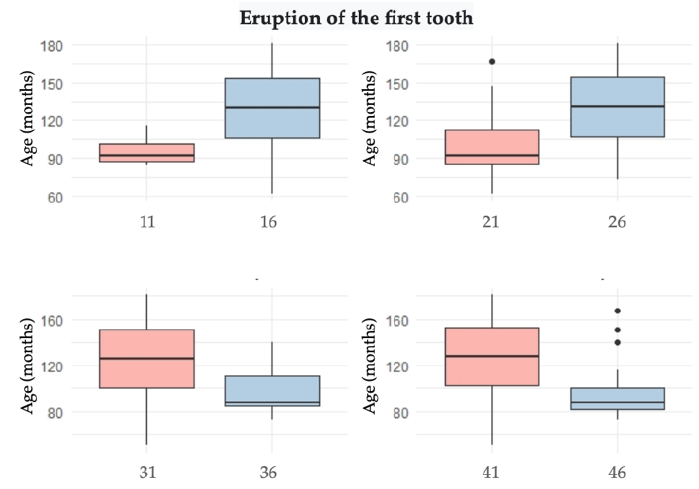
Figure 1. Box plot of age and first tooth.